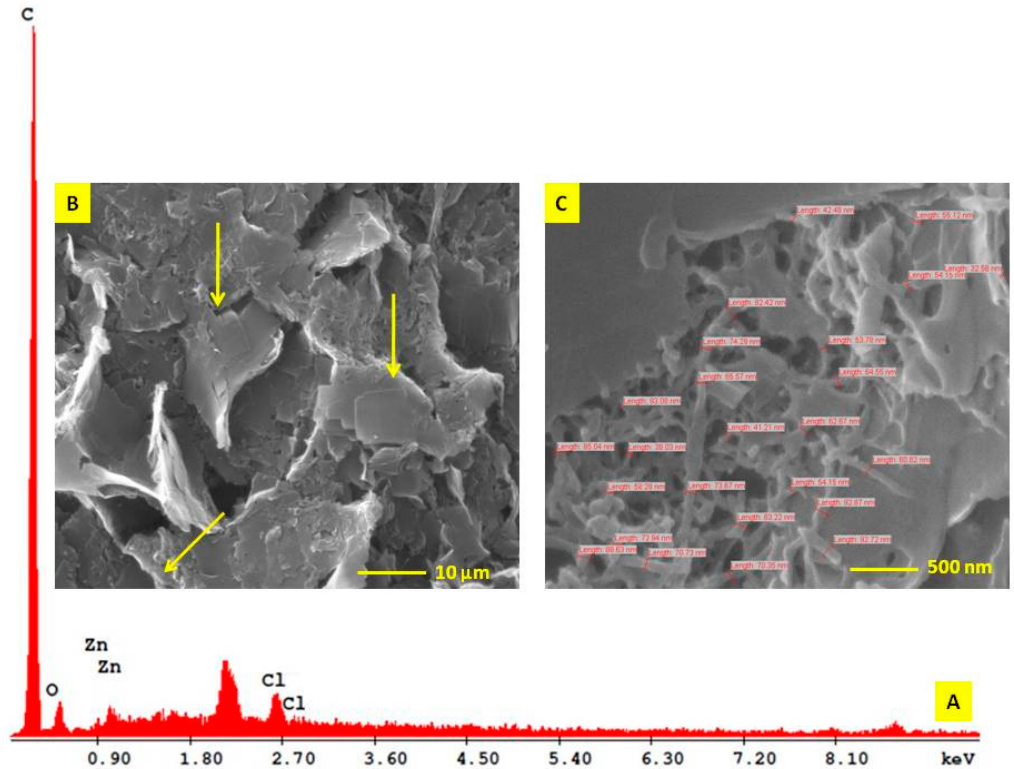
Figure 3. Energy dispersive X-ray spectra ( A ) and SEM image of EM2 + ZnCl 2 ; ( B ) – rough surface overview aspect with square shape ultrastructures – yellow arrows; ( C ) – trabecular aspect of square shape ultrastructures in a fracture area.